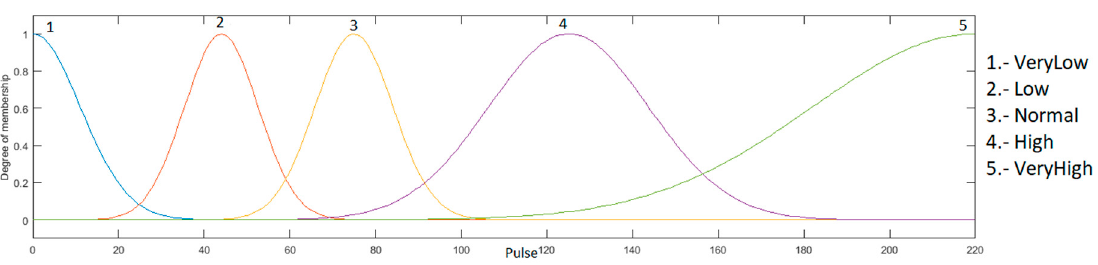
Figure 23. Optimized input heart rate with Gaussian MFs.